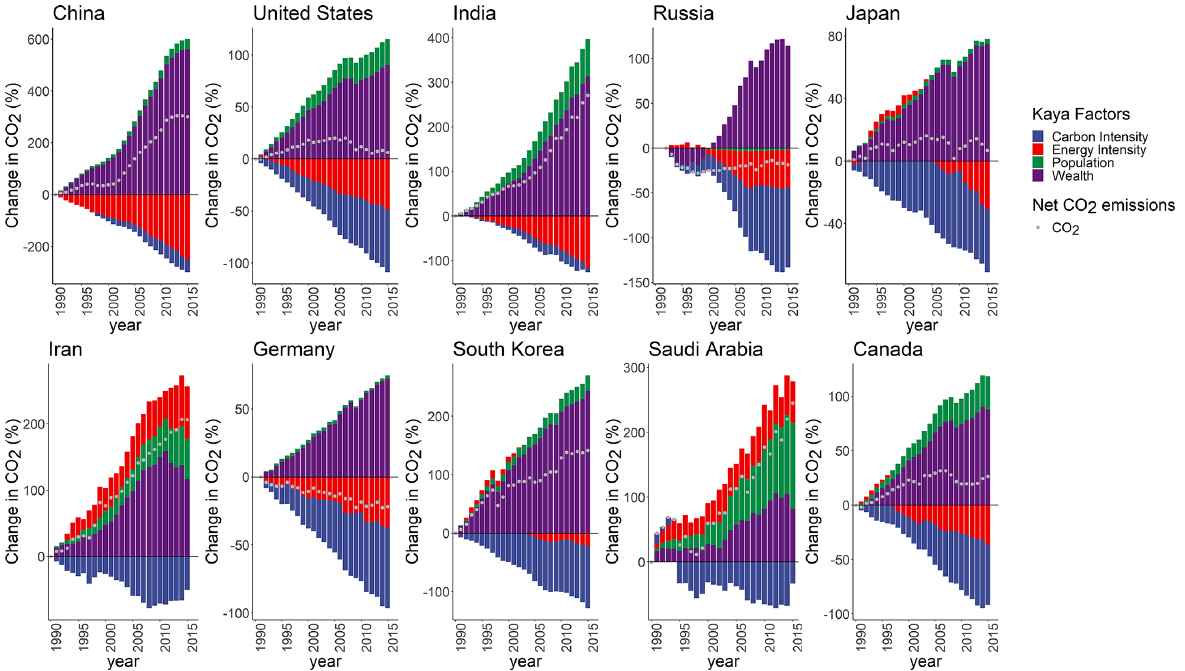
Figure 4. Log mean Divisia index (LMDI) decomposition of Kaya factors for the top 10 CO 2 -emitting countries. The Kaya factors are outlined in Eq. (3), and the decomposition calculation is outlined in Eqs. (4) and (5). Changes are relative to the reference year 1990 for all countries, except Germany (reference year 1991) and Russia (reference year 1992). Positive values indicate drivers of increases in emissions, while negative values indicate offsetting factors. Net CO 2 emissions relative to the reference year are presented by gray dots. The countries are shown in order, from top left to bottom right, of their total CO 2 emissions for the year